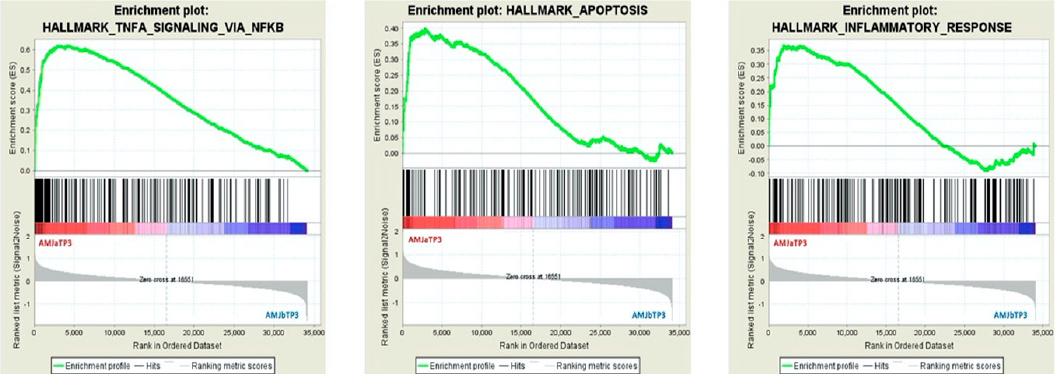
Figure 3. Enrichment plots of top three enriched Hallmark gene sets for the phenotype AMJ aTP3, compared to phenotype AMJ bTP3. Each enrichment plot shows profile of the running enrichment score and positions of gene set constituents on the rank ordered list; AMJ—treatment with original Aronia melanocarpa juice containing a total polyphenol amount of 11,771.09 mg gallic acid equivalent (GAE) / L, which corresponds to 1.17 g of total polyphenols per 100 mL of the allocated treatment (high dose); aTP—after treatment period; bTP—before treatment